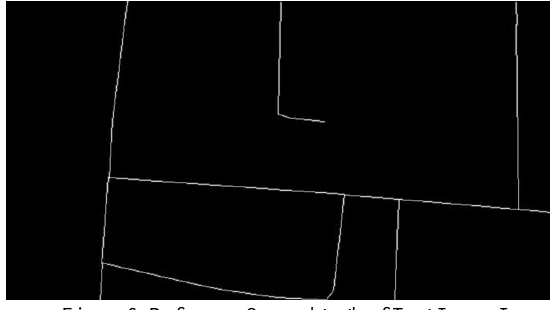
Figure 6. Reference Ground truth of Test Image